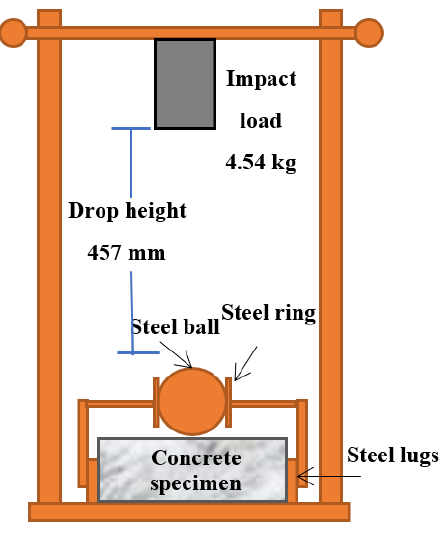
Figure 1. Testing apparatus of the ACI 544-2R repeated-impact test.